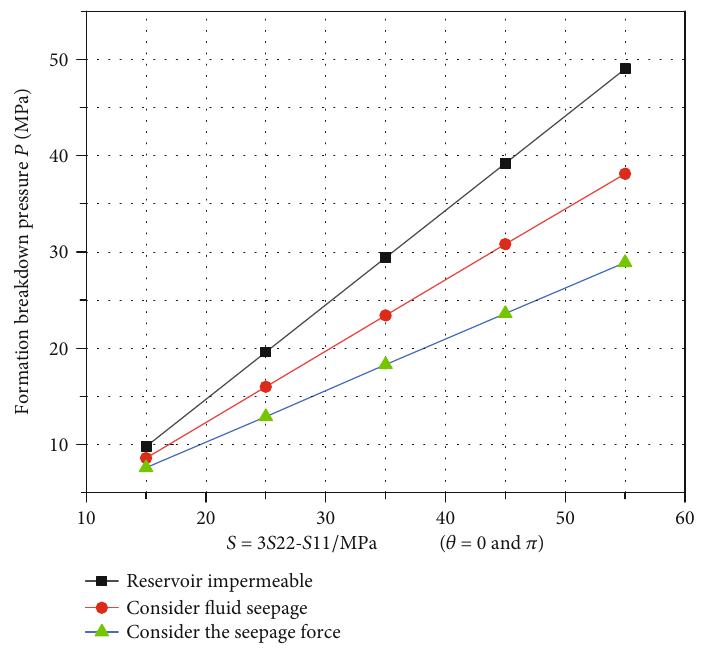
Figure 9: Formation breakdown pressures from the three cases when S 11 and S 22 increase